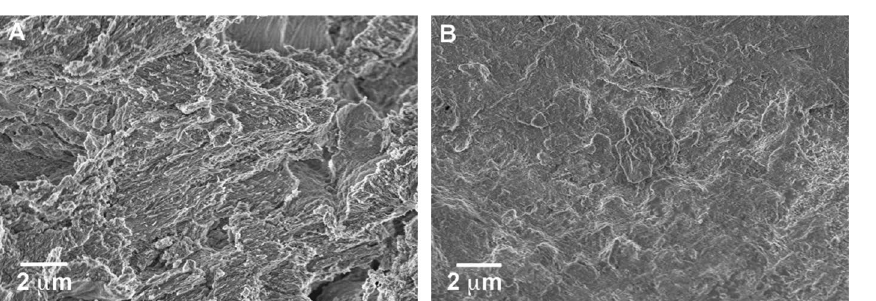
Figure 3. SEM micrographs registered at 10 kx of magnitude of two samples of bone from Muŝov66 before ( A ) and after ( B ) the consolidation